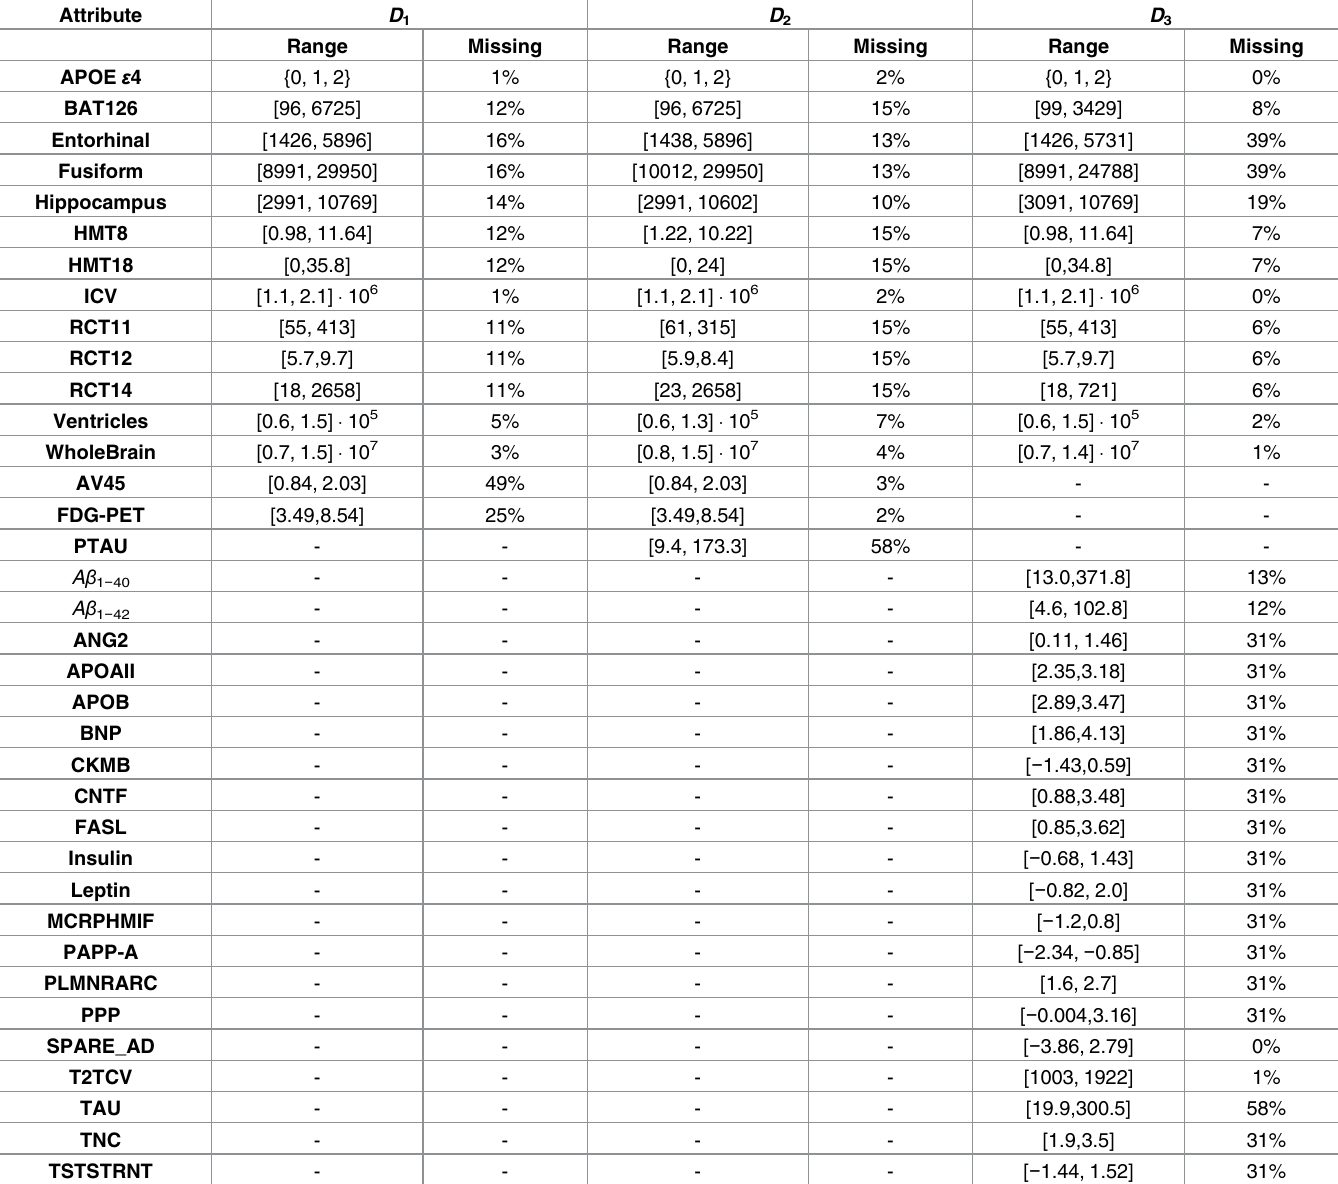
Table 3. Information about value range and percentage of missing values for biological attributes discussed in the text. Absenceof an attribute from a dataset is denotedwith “-” in the range and missing columns. Attribute D 1 D 2 D 3 Range